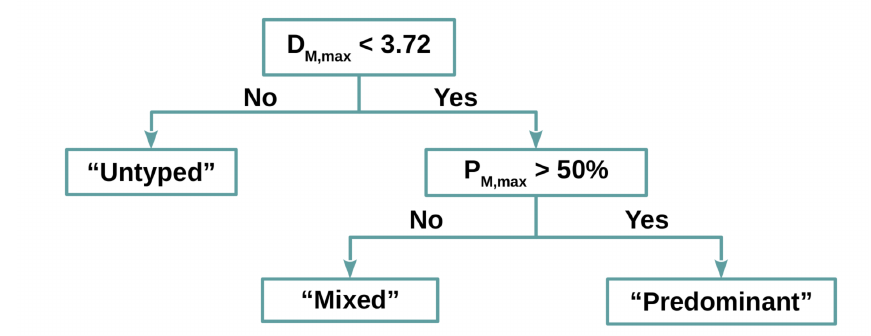
Figure 4. The decision tree used for the Mahalanobis classification procedure. Thresholds are applied to the Mahalanobis distance and the Normalized Probability